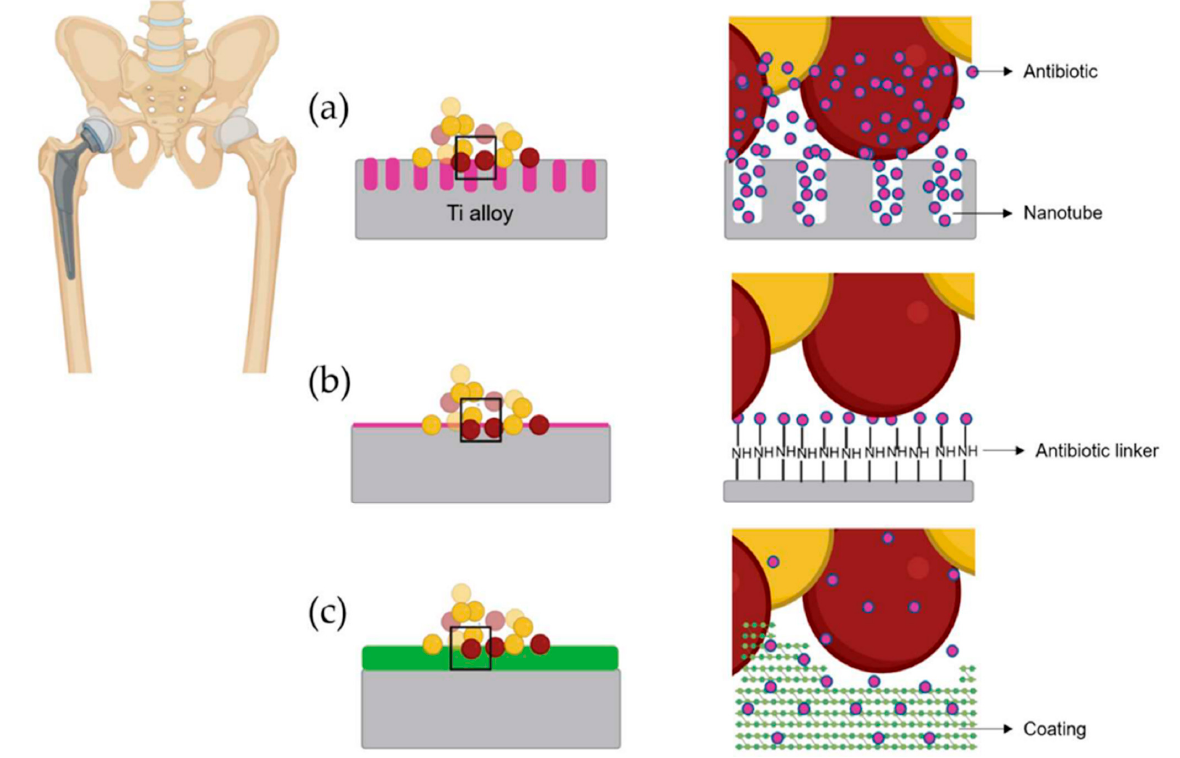
Figure 21. Several local antibiotic therapeutic techniques: ( a ) Nanotubes filled with antibiotics. ( b ) Ti alloy is covalently attached to an antibiotic. ( c ) Coating with antibiotics. Yellow denotes a living bacterium. Red indicates dead bacteria. Reprinted with permission from [136]. Copyright 2021